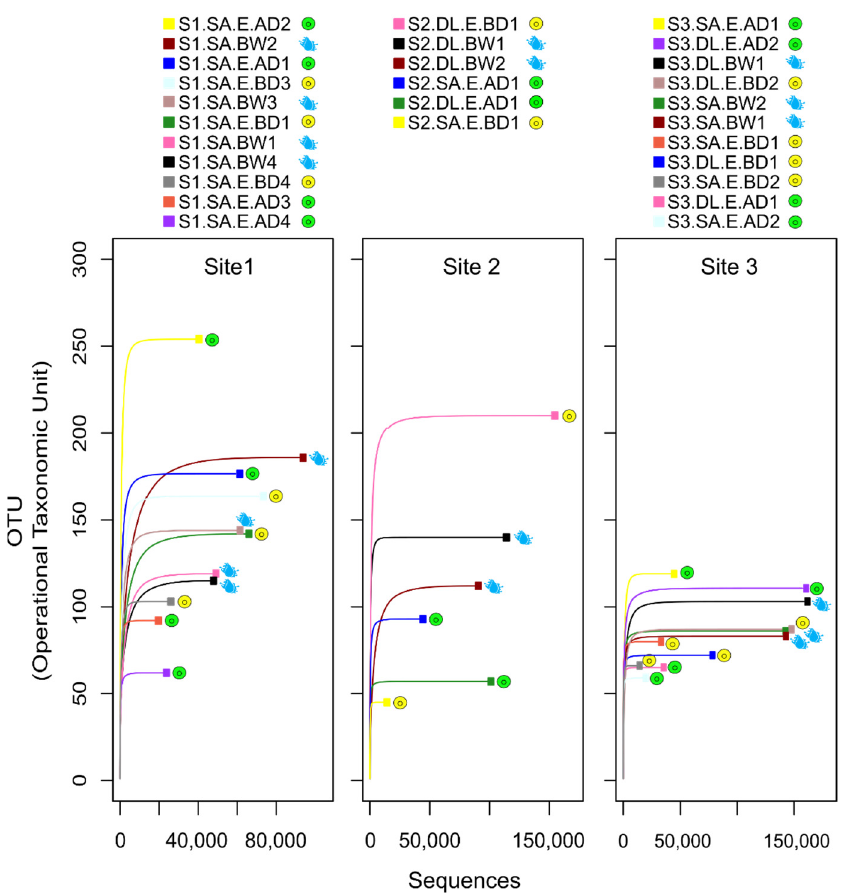
Figure 2. Rarefaction plots of the sequencing data from the 16S rRNA microbiome libraries. The rarefaction curves related to the eggs and water samples of each site (Site 1, Site 2, Site 3) are plotted separately. Symbols show different types of samples: eggs before disinfection = yellow circle; eggs after disinfection = green circle; BS water = blue drop. The sequences generated from each of the 28 libraries reached a plateau for all the samples, revealing that all bacterial diversity was covered. The rarefaction curves were plotted using the rarecurve function in the R package vegan (v 2.5-6). Information about the sample labels is presented in the legend of Figure 1.